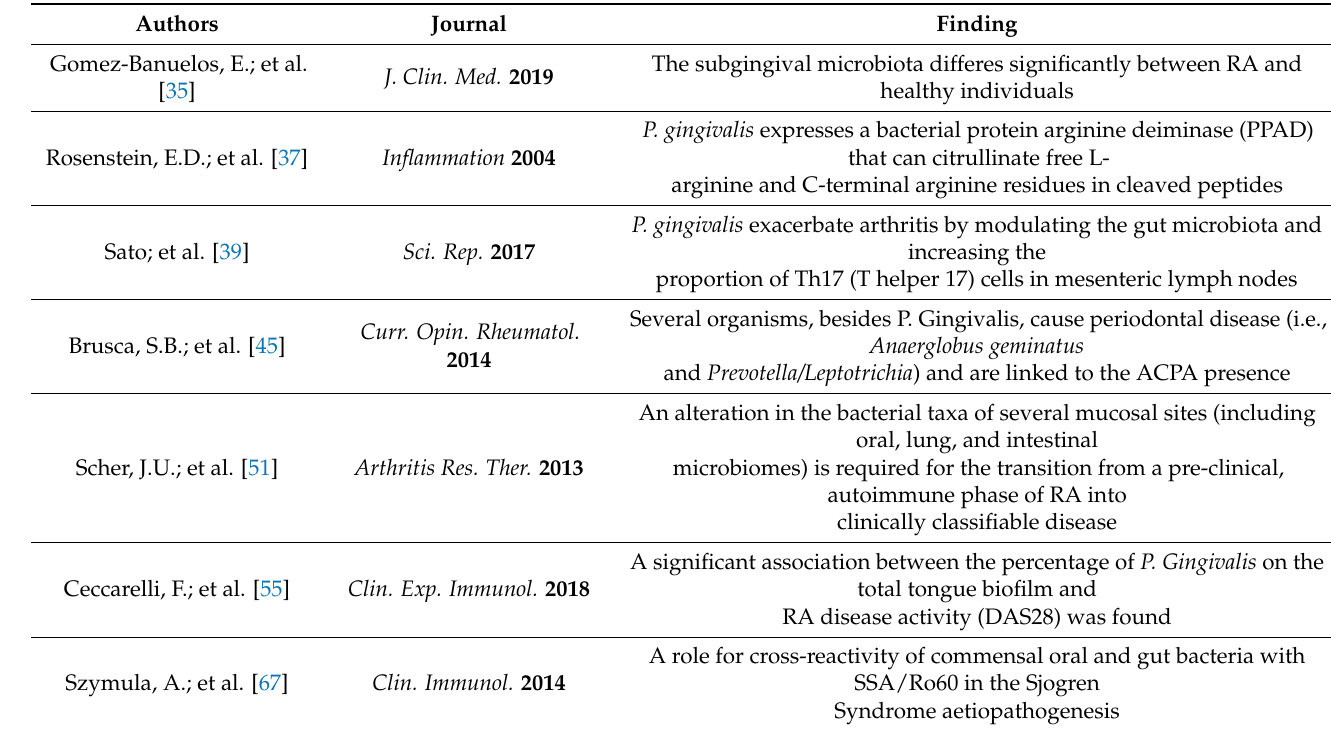
Table 1. Literature data linking the oral microbiota with the pathogenesis of progression of rheumatic